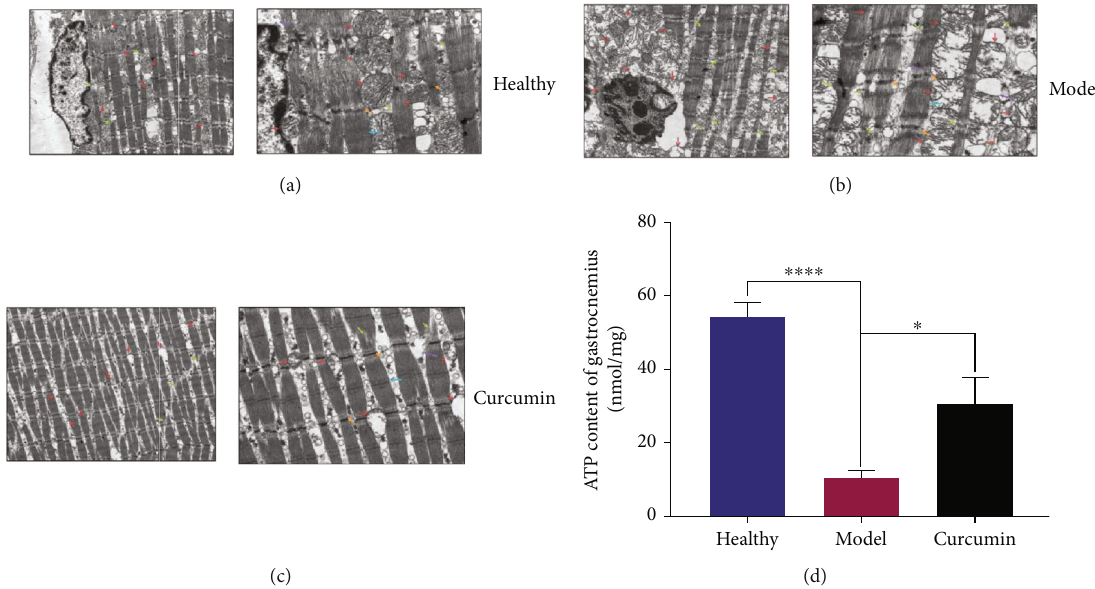
Figure 5: Curcumin alleviates mitochondrial dysfunction and increased ATP production in gastrocnemius of TNBC mice. (a – c) Transmission electron microscope observation of the gastrocnemius in the healthy group, the model group and the curcumin group (green: myo fi brils; orange: sarcomere Z-line; blue: H band; reddish-brown: mitochondria; purple: edema; left: 20,000x magni fi cation; right: 50,000x magni fi cation). (d) Statistical analysis of ATP content in gastrocnemius tissue of mice in three groups ( n = 4 /group). ∗ p < 0 : 05 and ∗∗∗∗ p < 0 : 0001 by t -test, compared to the model group. Data were shown as mean ± standard errorsof the mean